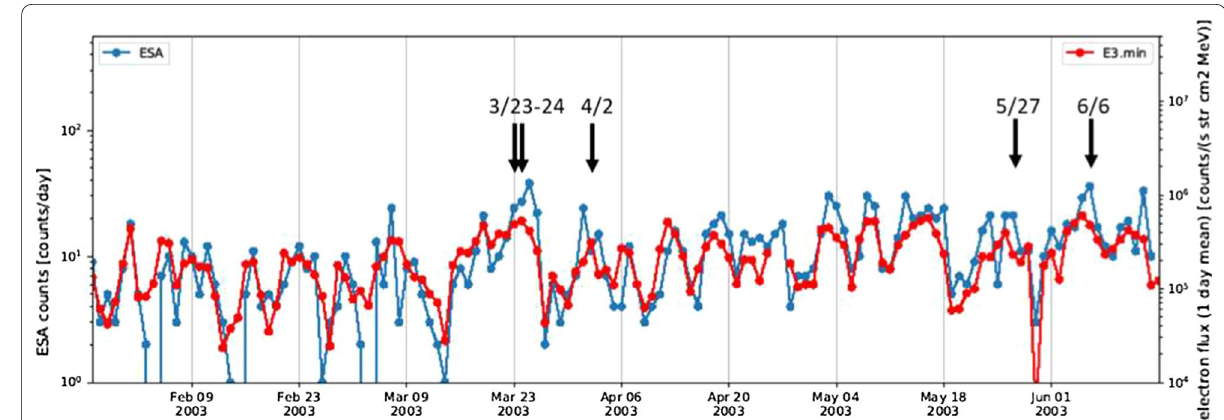
Fig. 8 Daily noise counts of the ESA and daily mean differential electron flux of SDOM (Ch.3: 0.59–1.18 meV) from Jan. 2003 to Jun. 2003 are plotted by blue and red lines, respectively. The occurrence of the ESA satellite anomaly is shown by